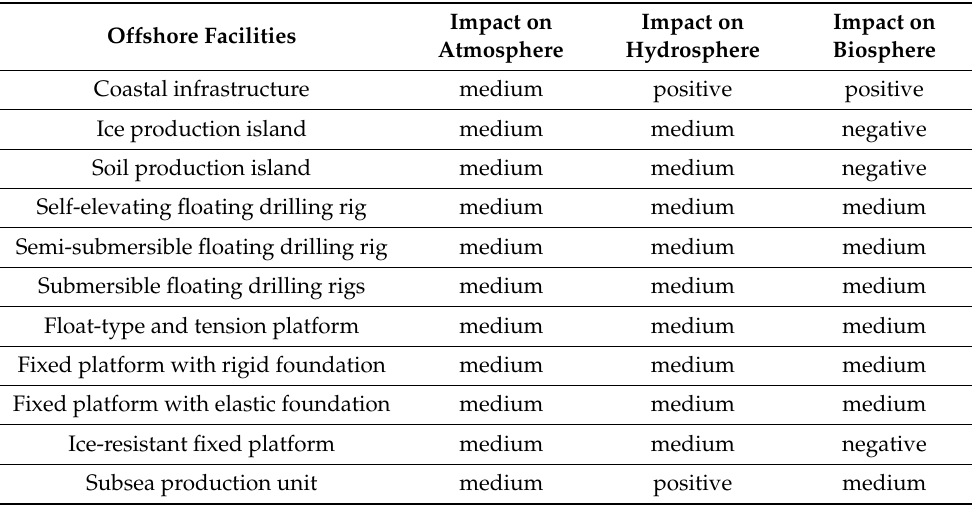
Table 4. The applicability analysis of offshore oil and gas facilities (environmental factor)